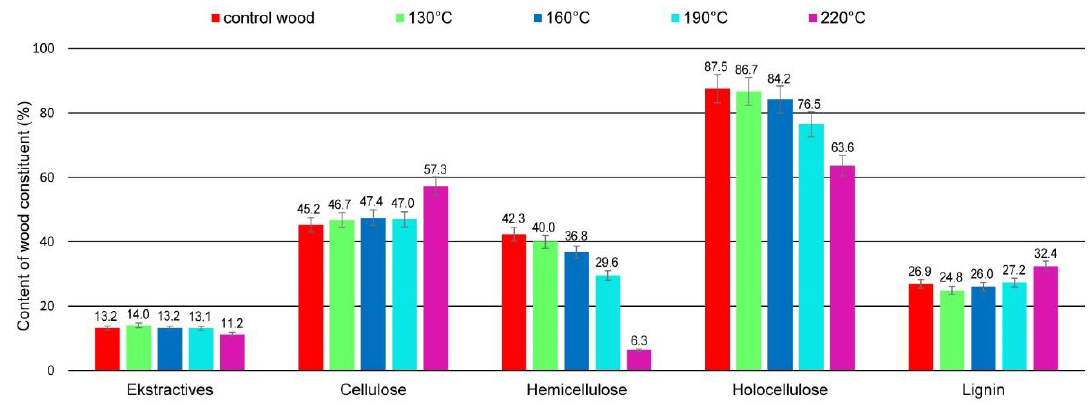
Table 3. Mass loss and total carbon content in modified